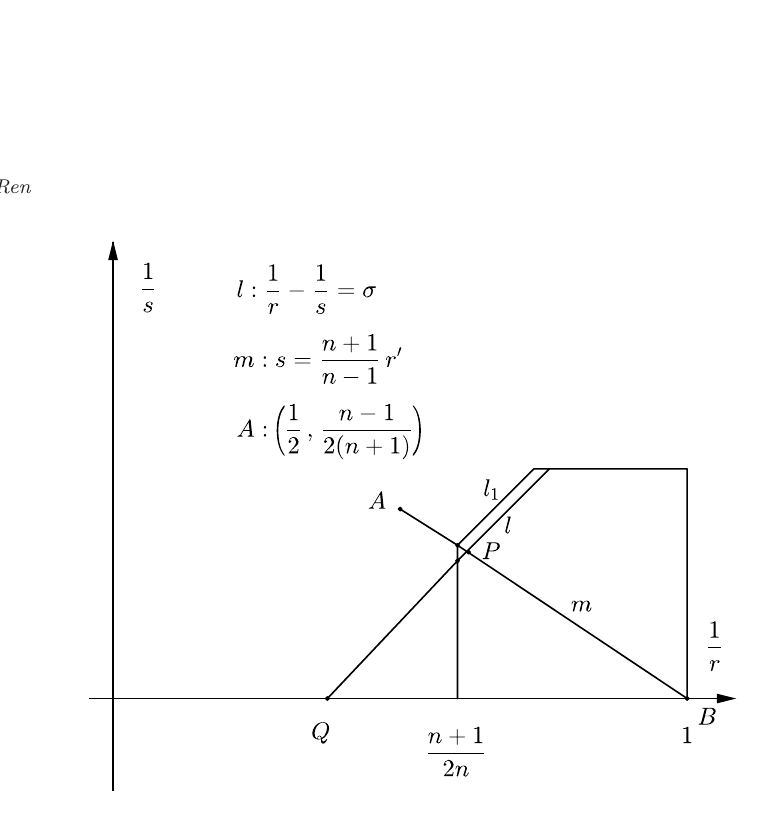
Fig. 2. Interpolation argument